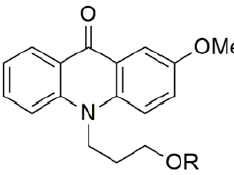
Figure 1. Structure of N-substituted acridones as suitable probes for intracellular polarity